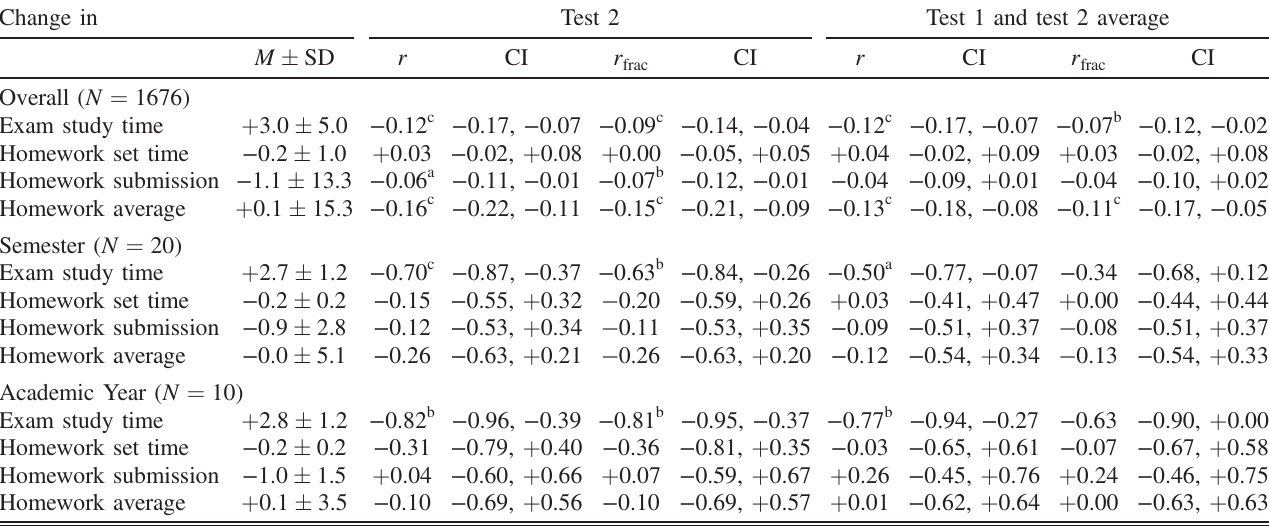
TABLE III. Summary of the correlation of time on task and change of time on task with the score on the second in-semester examination and the average on the first two in-semester evaluations. The correlation is represented by r ; r with the fractional change in the variable. CI represents the 95% confidence interval for the correlation. Change in exam study time and homework time is measured in hours; change in homework average and submission rate in